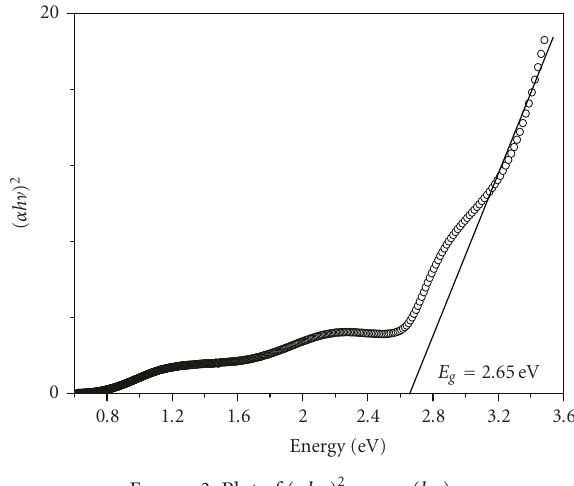
Figure 3: Plot of ( αhυ ) 2 versus ( hυ ).